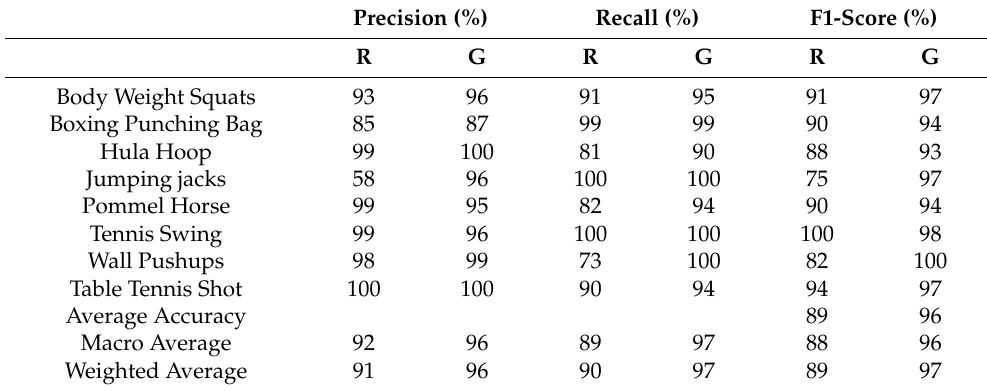
Table Tennis Shot